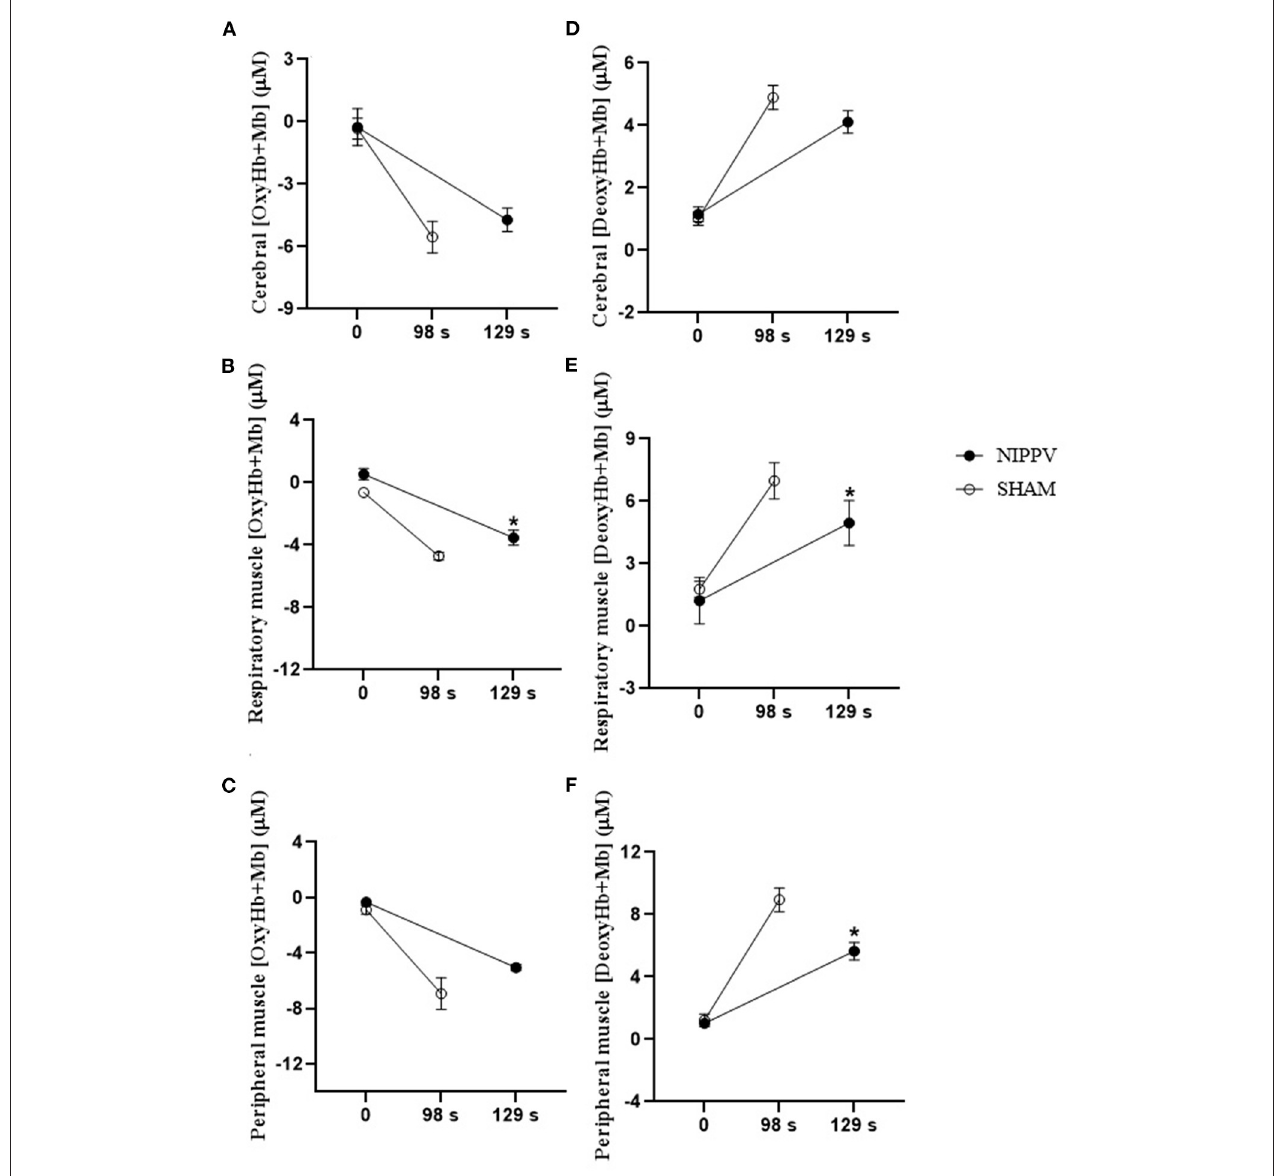
FIGURE 5 | A comparative analysis in Cox, peripheral, and respiratory muscle during rest and limit of tolerance (Tlim) (SHAM 98 s and NIPPV 129 s). * p < 0.05, ANOVA two-way. (A) (OxyHb+Mb) cerebral; (B) (OxyHb + Mb) peripheral muscle (vastus lateralis muscle); (C) (OxyHb + Mb) respiratory muscle (intercostal muscle); (D) (DeoxyHb + Mb) cerebral p interaction: 0.03; (E) (DeoxyHb + Mb) respiratory muscle (intercostal muscle); (F) (DeoxyHb + Mb) peripheral muscle (right vastus lateralis muscle). indicated that respiratory muscle unloading through NIPPV resulted in a redirection of blood flow from respiratory to latter muscle group during